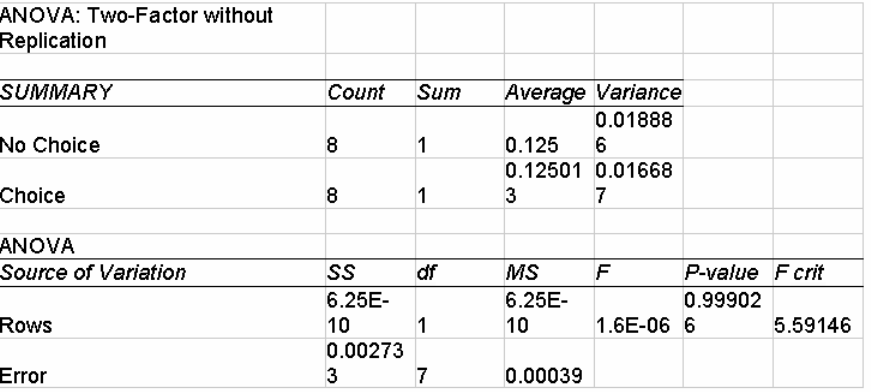
Table 1. Academic performance of "Choice" and "No Choice"